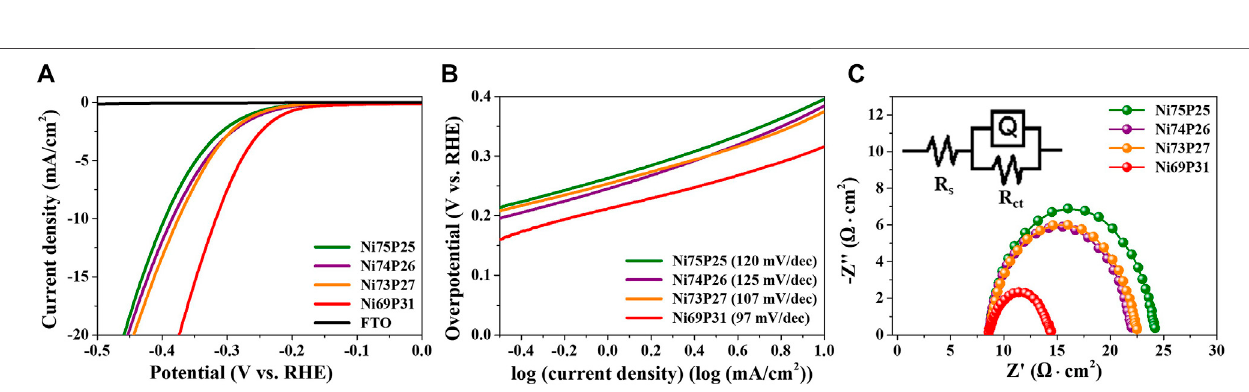
FIGURE4| ElectrocatalyticpropertiesoftheamorphousNi-Pelectrodepositsasafunctionofcontentsofphosphorous: (A) polarizationcurves, (B) Tafelplots,and (C) Nyquist plots.